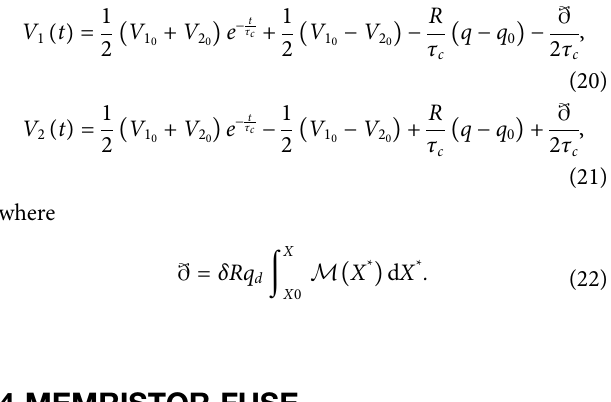
Frontiers in Communications and Networks |